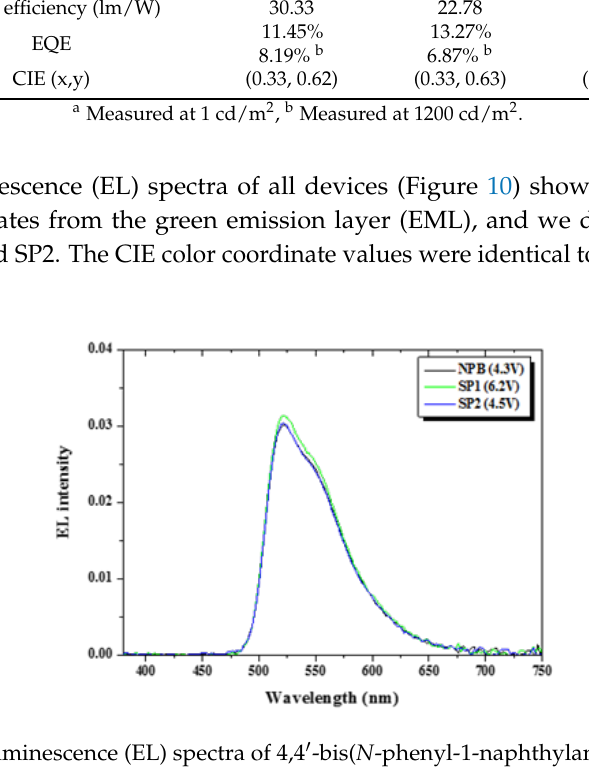
Figure 10. Electroluminescence (EL) spectra of 4,4′-bis( N -phenyl-1-naphthylamino)biphenyl (NPB), diphenylacridine (SP1), and phenothiazine (SP2)